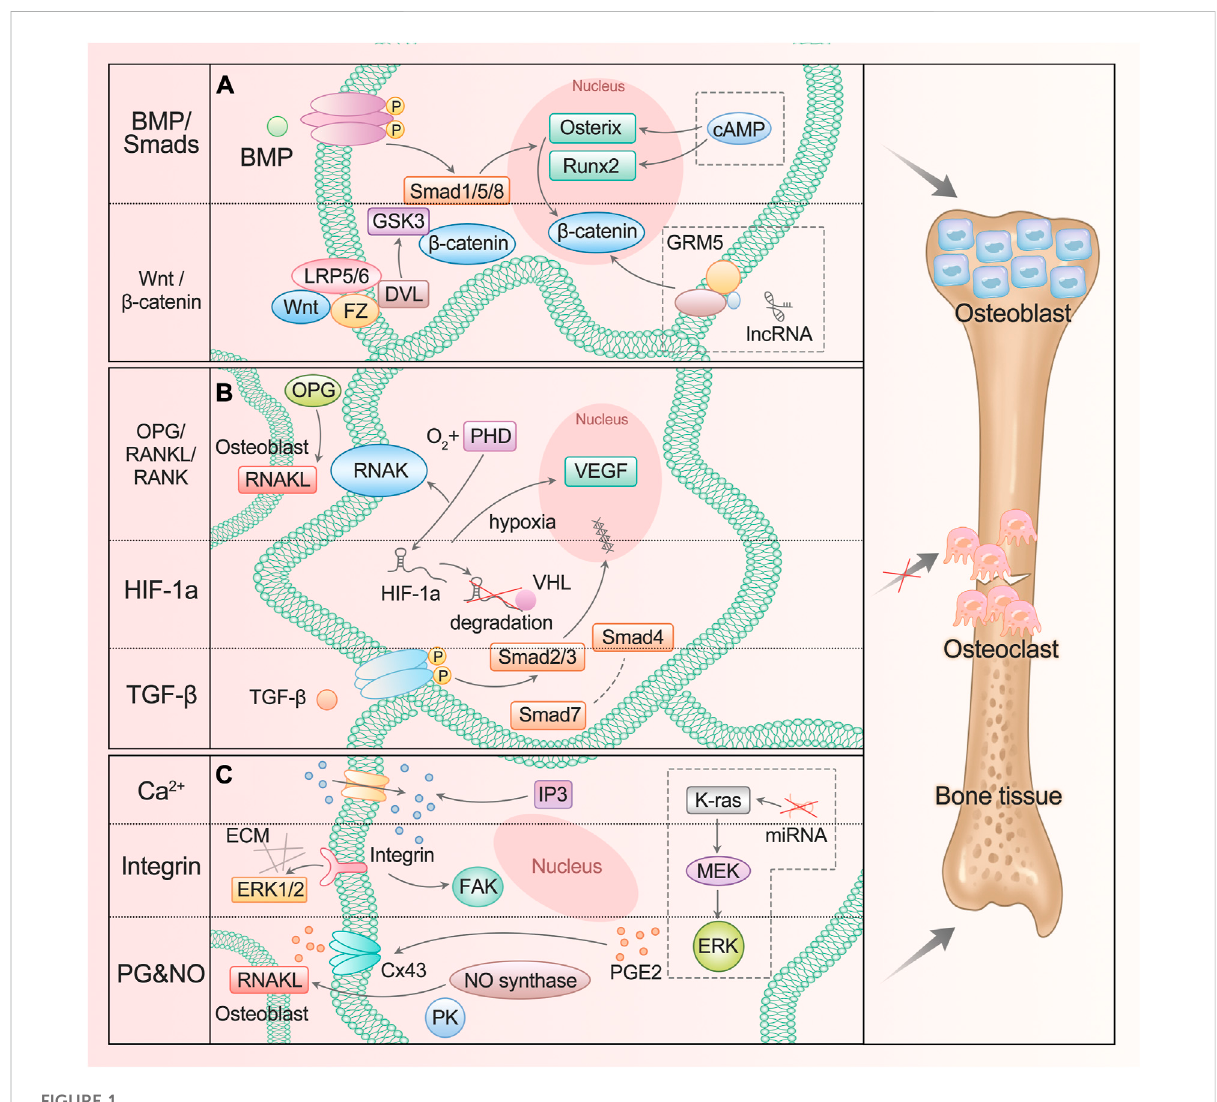
FIGURE 1 ASC mediates diverse signals to participate inosteogenesis. (A) BMP/Smads and Wnt/GSK-3 β / β -Catenin pathwayspromoteASC differentiation intoosteoblast.ThelncRNAparticipatesintheregulationoftheWnt/ β -Cateninsignalingpathway,andcAMPcanactonRunx2andOsterixgenes. (B) OPG/RANKL/RANK, HIF-1a, and TGF- β pathways inhibit ASC differentiation into osteoclast. (C) Ca 2+ , integrin, PG, and NO signaling participate in bone resorption and formation. The miRNA enhances the activation of the K-ras/MEK/ERK pathway, which contributes to bone